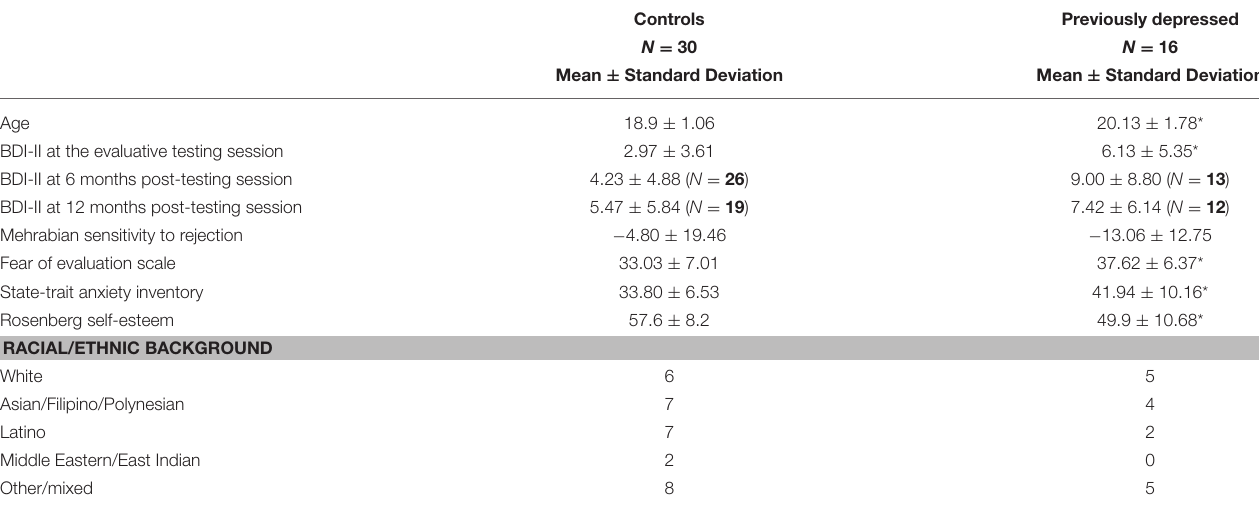
TABLE 1 | Sociodemographic data and psychological profile of study